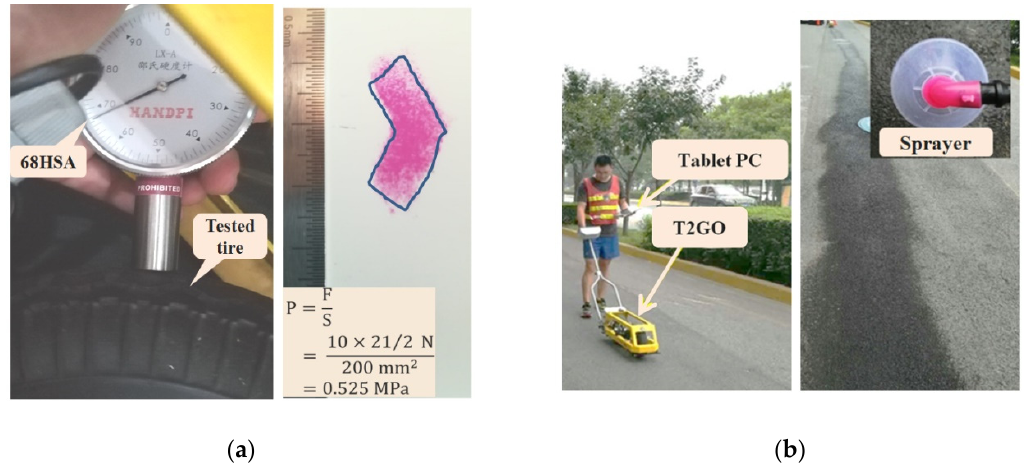
Figure 4. ( a ) Rubber stiffness and contact pressure measurement; ( b ) skid resistance measurement.